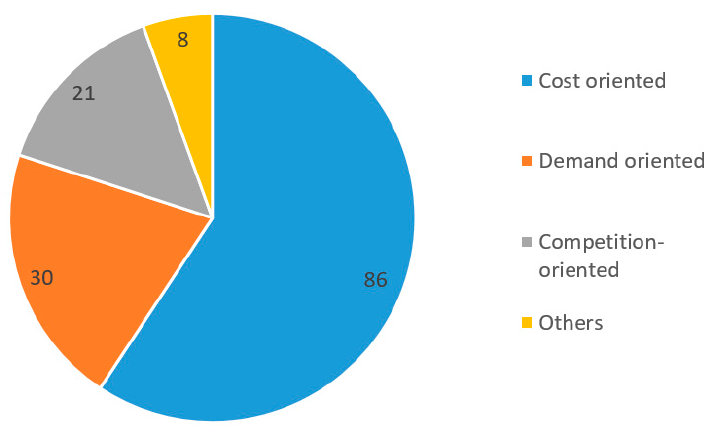
Figure 2. Usage of pricing methods (absolute frequency).